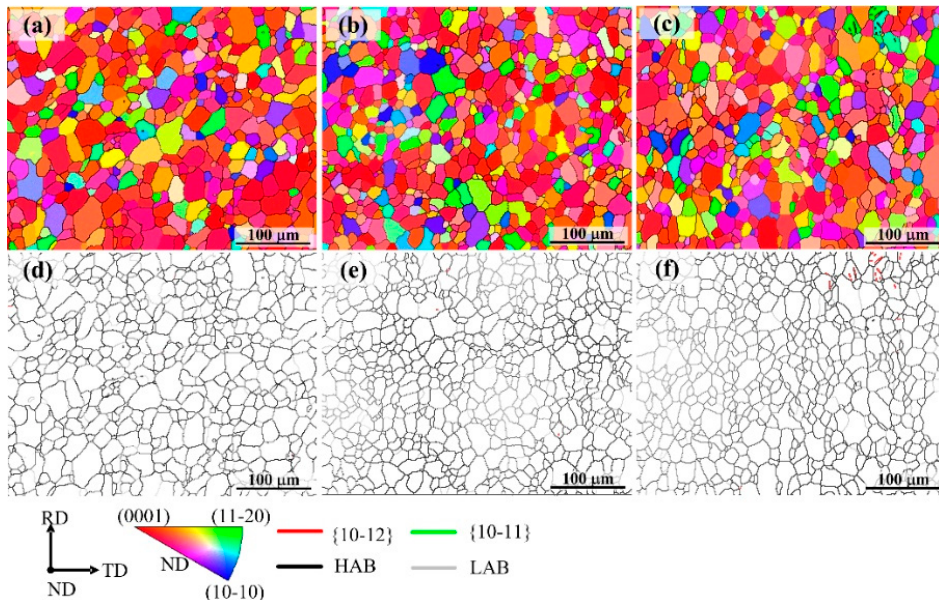
Figure 7. ( a – c ) Inverse pole figure (IPF) maps and ( d – f ) grain boundaries (GB) maps of the ECAR-CB-A AZ31 Mg alloy samples prepared at different final rolling temperatures: ( a , d ) 350 °C, ( b , e ) 450 °C and ( c , f ) 550 °C.